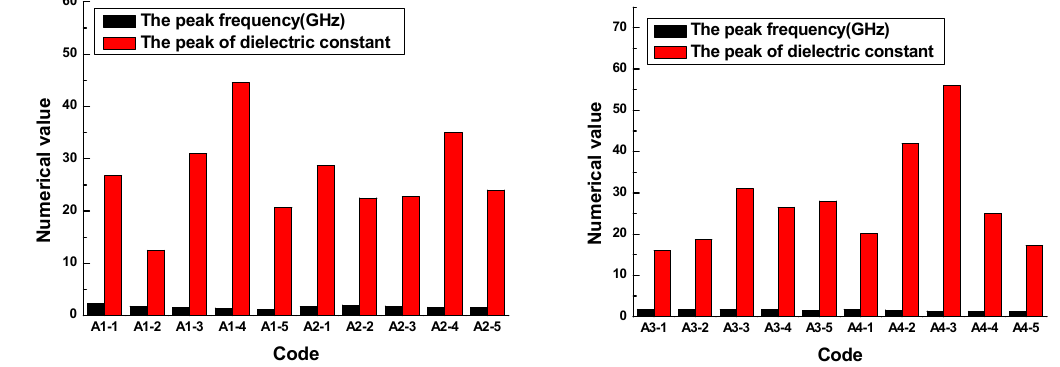
Figure 10. The peak and peak frequency of the dielectric constant of the rubber samples.